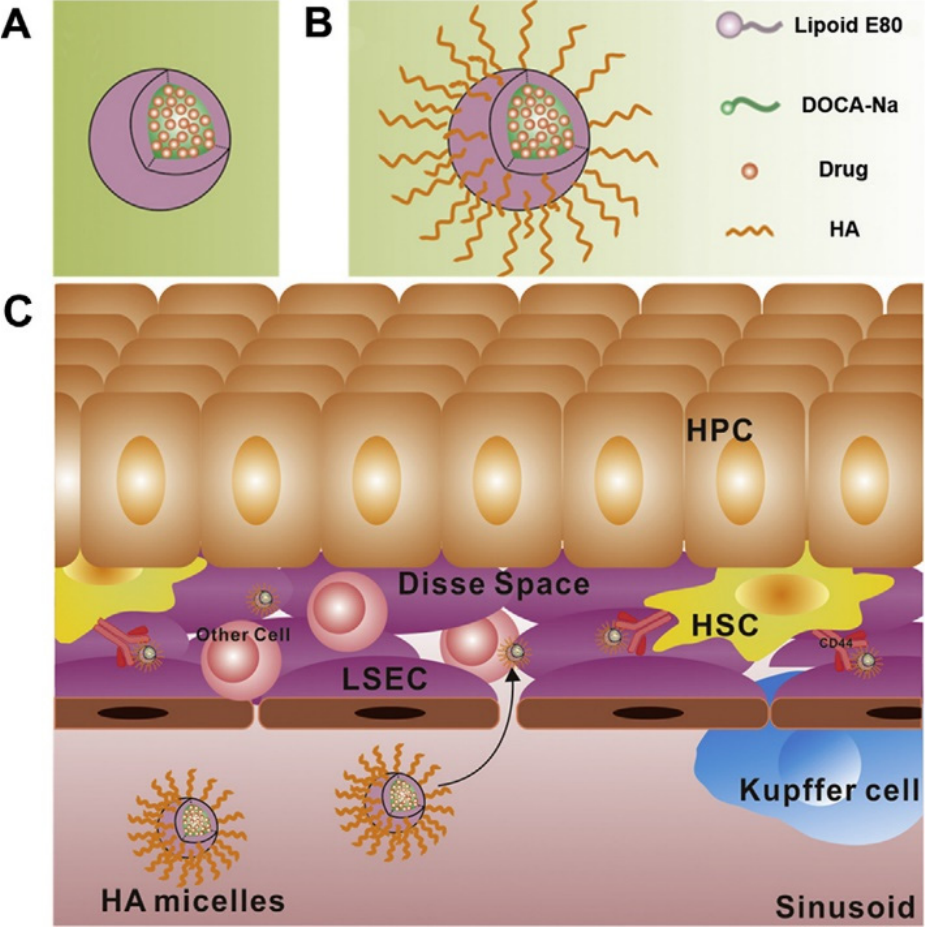
Figure 6. ( A ) Phospholipid bile salt micelles and ( B ) HA micelles fabrication. ( C ) Strategic illustration for the application of HA micelles to target HSCs. Reproduced with permission from ref. [139].